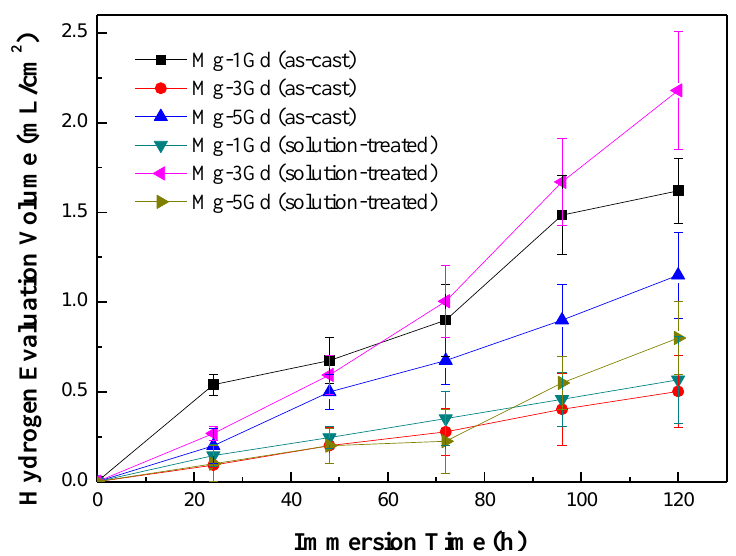
Figure 7. The hydrogen evolution curves of the Mg-xGd alloys under different conditions based on static immersion tests.